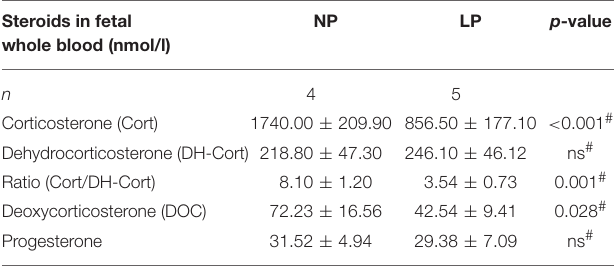
TABLE 4 | Steroid analysis of fetal whole blood. Steroids in fetal whole blood